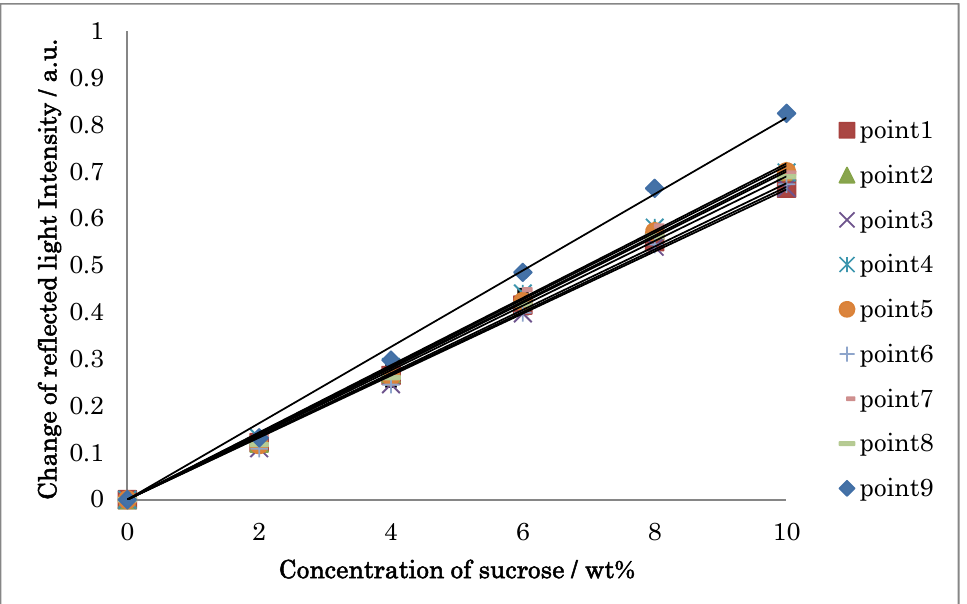
Figure 9. Calibration curve for sucrose on nine sensing